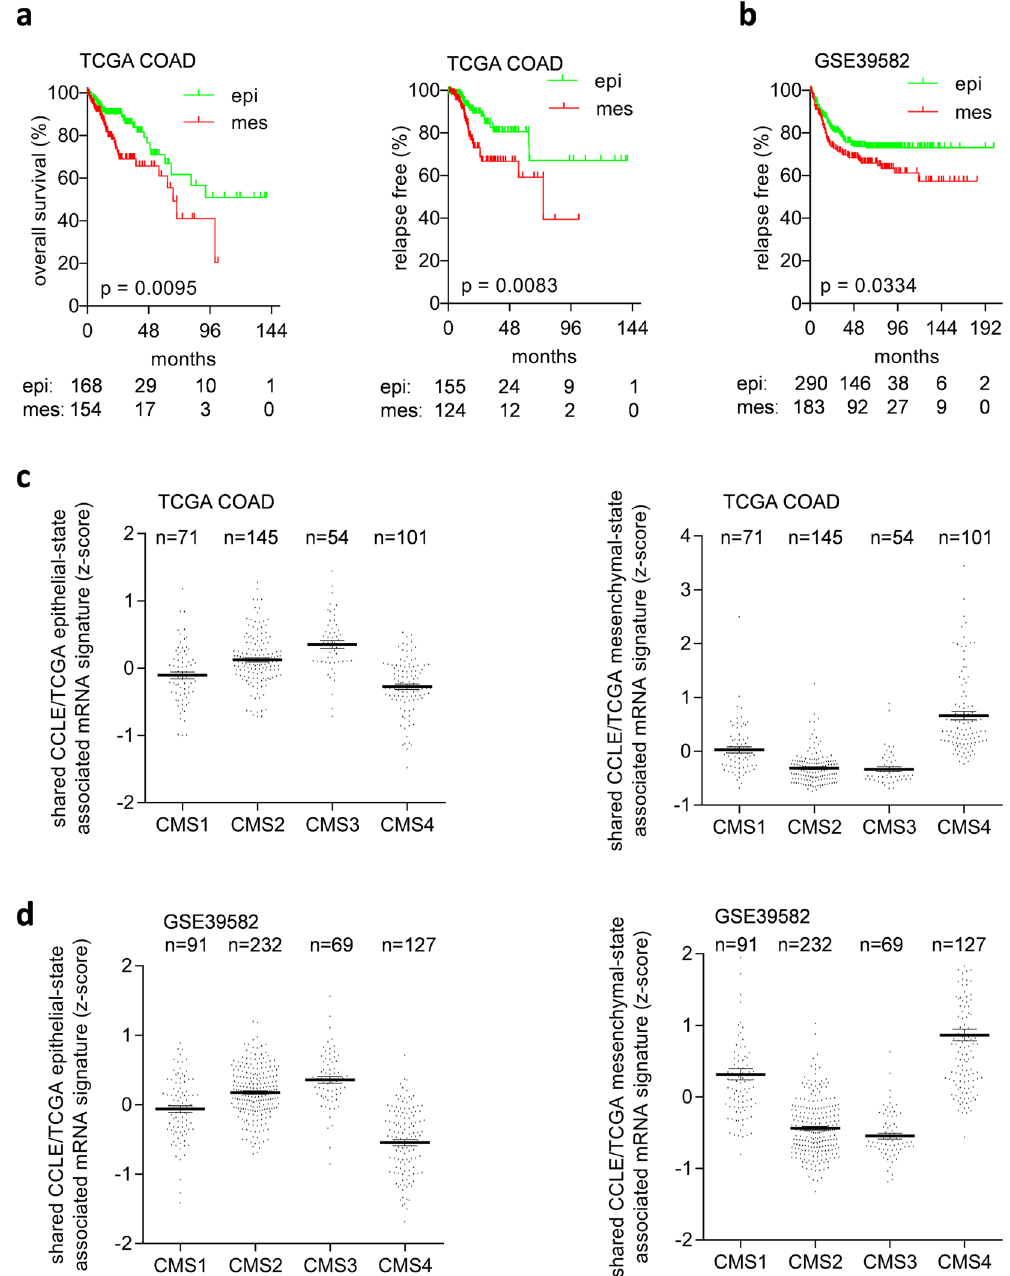
Figure 2. EMT-associated mRNA signatures are associated with survival in colon cancer patients. ( a,b ) Associations of epithelial state (epi) and mesenchymal state (mes) associated groups of samples with survival in TCGA COAD ( a ) and the GSE39582 datasets ( b ) (epi and mes groups of samples were defined by K-means clustering based on expression of the shared CCLE/TCGA epithelial state- or mesenchymal state-associated mRNAs. ( c,d ) Association of the shared TCGA/CCLE epithelial state- and mesenchymal state-associated mRNA signatures with the consensus molecular subtypes (CMS) of colorectal cancer in TCGA ( c ) and GSE39582 datasets ( d